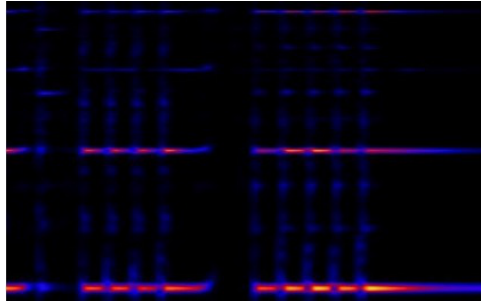
Fig. 17. Group II’s spectrogram of the harmonic ringing produced when notes E4 and E5 when E3 are played